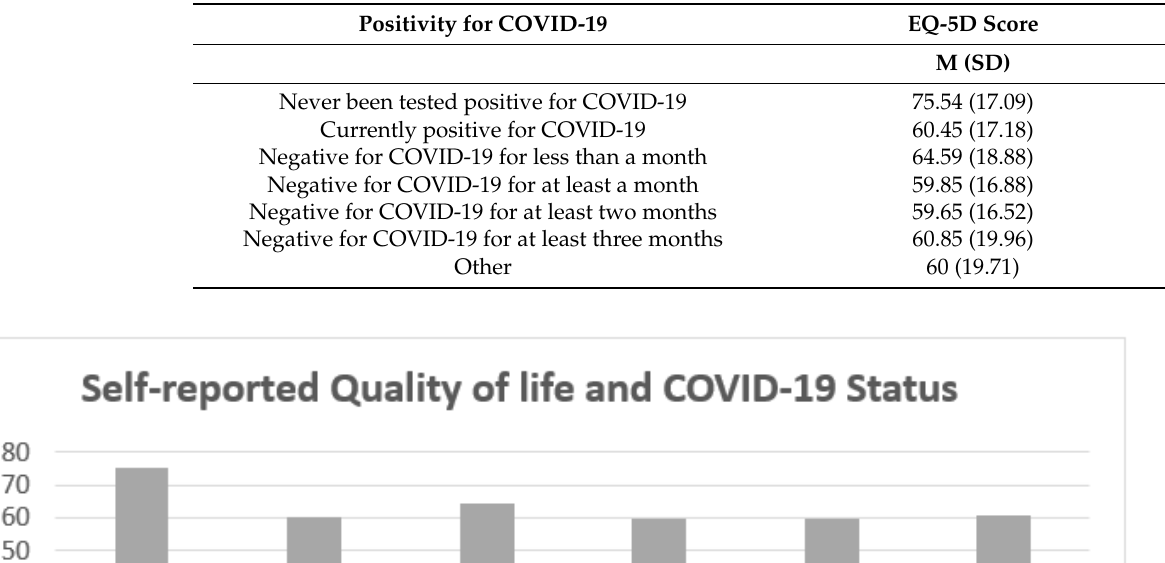
Table 6. Mean values (M) and standard deviation (SD) for subjects who responded to individual items